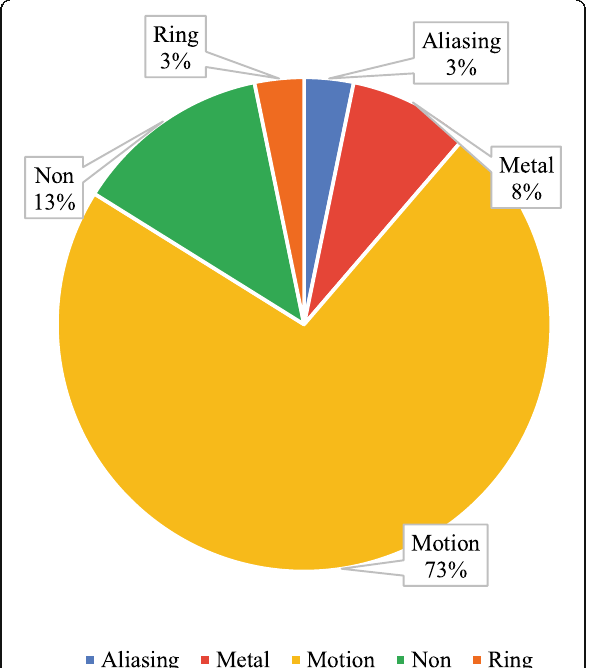
Fig. 6 The common types of artifacts encountered while working